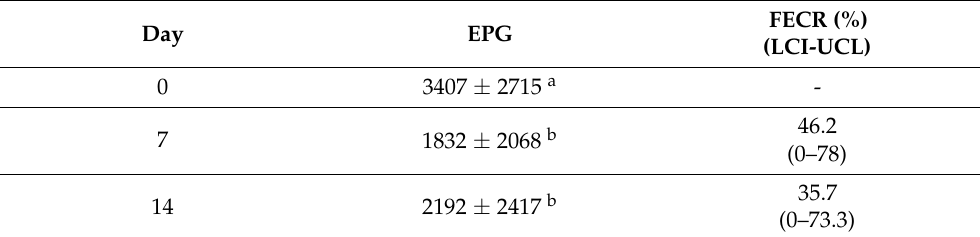
Table 3. Mean egg per gram (EPG) counts ( ± SD) and fecal egg count reduction percentage (FECR) obtained at 7 and 14 days after the oral administration of an emulsion containing R-CNE + IVM (100 mg/kg and 0.2 mg/kg, respectively) on day 0 and the oral administration of R-CNE alone as an emulsion on days 1, 2, and 3 (100 mg/kg every 24 h) to lambs ( n = 9) artificially infected with resistant H. contortus